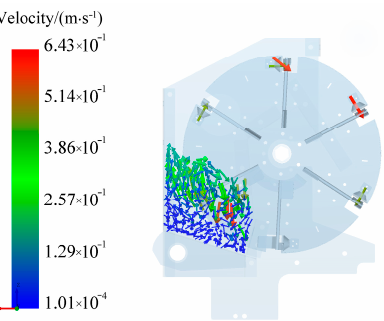
Figure 10. Garlic seed movement when the population was above 320